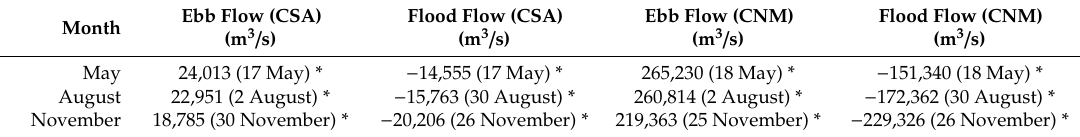
Table 5. Maximum ebb flow and flood flow values in m 3 / s for CSA and CNM’s simulated